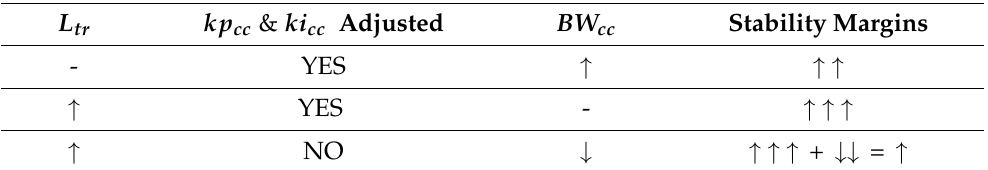
Table 3. Impact of current controller and transformer leakage inductance in LFO stability. Arrows ↑ stands for increments and ↓ stands for decrements.